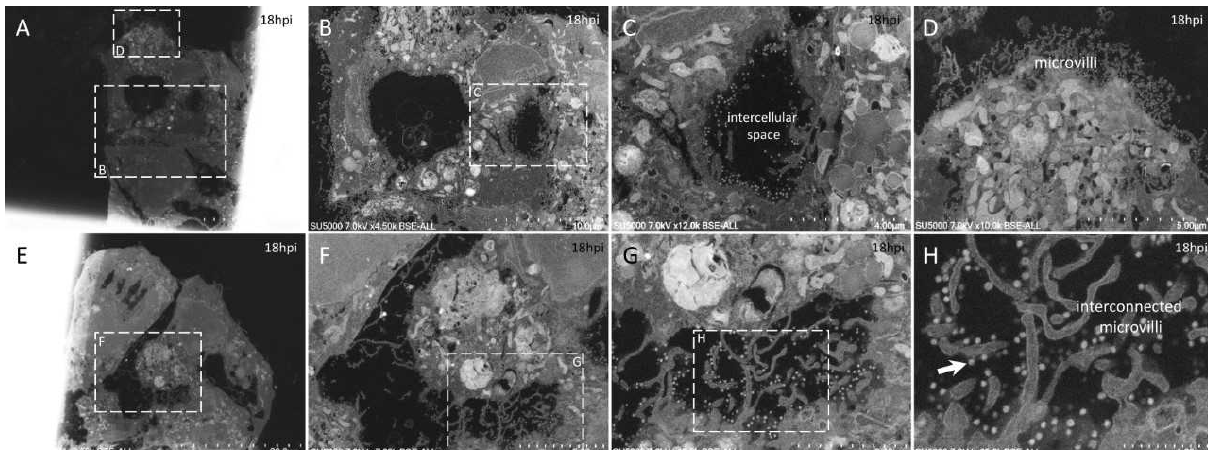
Figure 6. Ultra-thin sections of SARS-CoV-2-infected Vero E6 cells: 18 hpi. ( A – D ): Neighboring cells harboring extracellular SARS-CoV-2 particles at the level of the intercellular space ( C ) or at the level of peripheral microvilli ( D ). ( E – H ): A cellular cluster with two cells facing each other with intermingled microvilli enriched in SARS-CoV-2 particles ( H ; arrow).